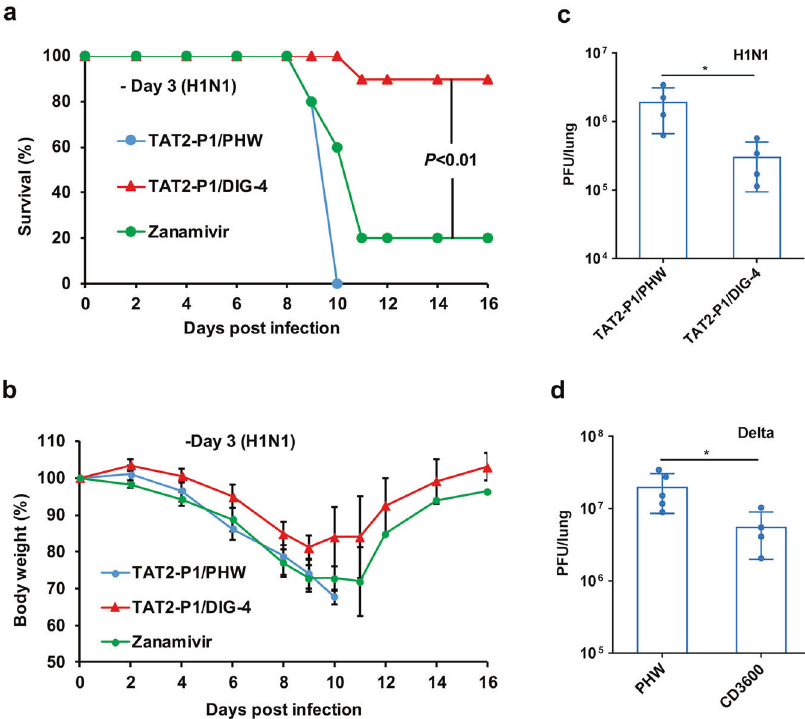
Fig. 4 One dose of TAT2-P1/DIG showed rapid-onset prophylactic protection on infected animals. a The protective ef fi cacy of antivirals administrated to mouse lungs 3-day before A(H1N1)pdm09 virus challenge. TAT2-P1/DIG-4 (20 µg/5 µg, n = 10), zanamivir (40 µg, n = 5), or TAT2-P1/PHW (20 µg/5 µg, n = 5) were intratracheally inoculated into corresponding mice 3-day before A(H1N1)pdm09 virus challenge. b The body weight changes of infected mice corresponding to ( a ). c Viral loads in H1N1-infected mouse lungs treated with TAT2-P1/PHW or TAT2-P1/ DIG-4 at 3-day before virus challenge. Viral titers were measured at 2-day post infection by plaque assay. d CD3600 could inhibit delta SARS- CoV-2 replication in hamster lungs. TAT2-P1/CD3600 (50 µg/12.5 µg, CD3600, n = 4) was inoculated to hamster lungs at day 1 before SARS- CoV-2 (Delta) challenge. TAT2-P1/PHW (PHW, n = 5) was given to hamster lungs at day 1 before viral challenges. Lung tissues were collected at 2-day post infection for measuring viral loads by plaque assay. Data were presented as mean ± SD of 4 – 5 hamsters in each group. * indicates P < 0.05, calculated by the two-tailed Student ’ s t